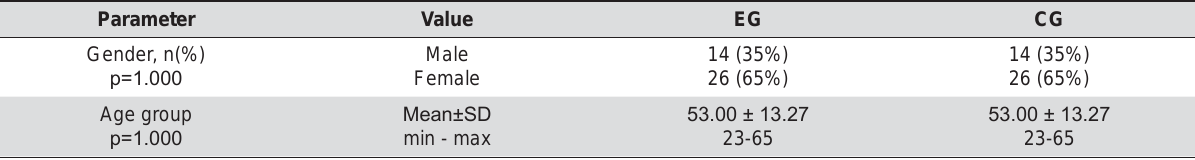
Table 1- Demographic characteristics of the studied population